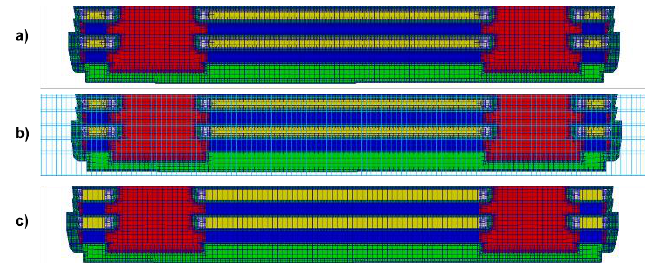
Figure 4. Definition of the full-scale model: Cells are agglomerated in turbulator layers in order to obtain 2D mesh. Steps of the process: ( a ) Base mesh; ( b ) agglomeration grid and ( c ) final agglomerated grid.